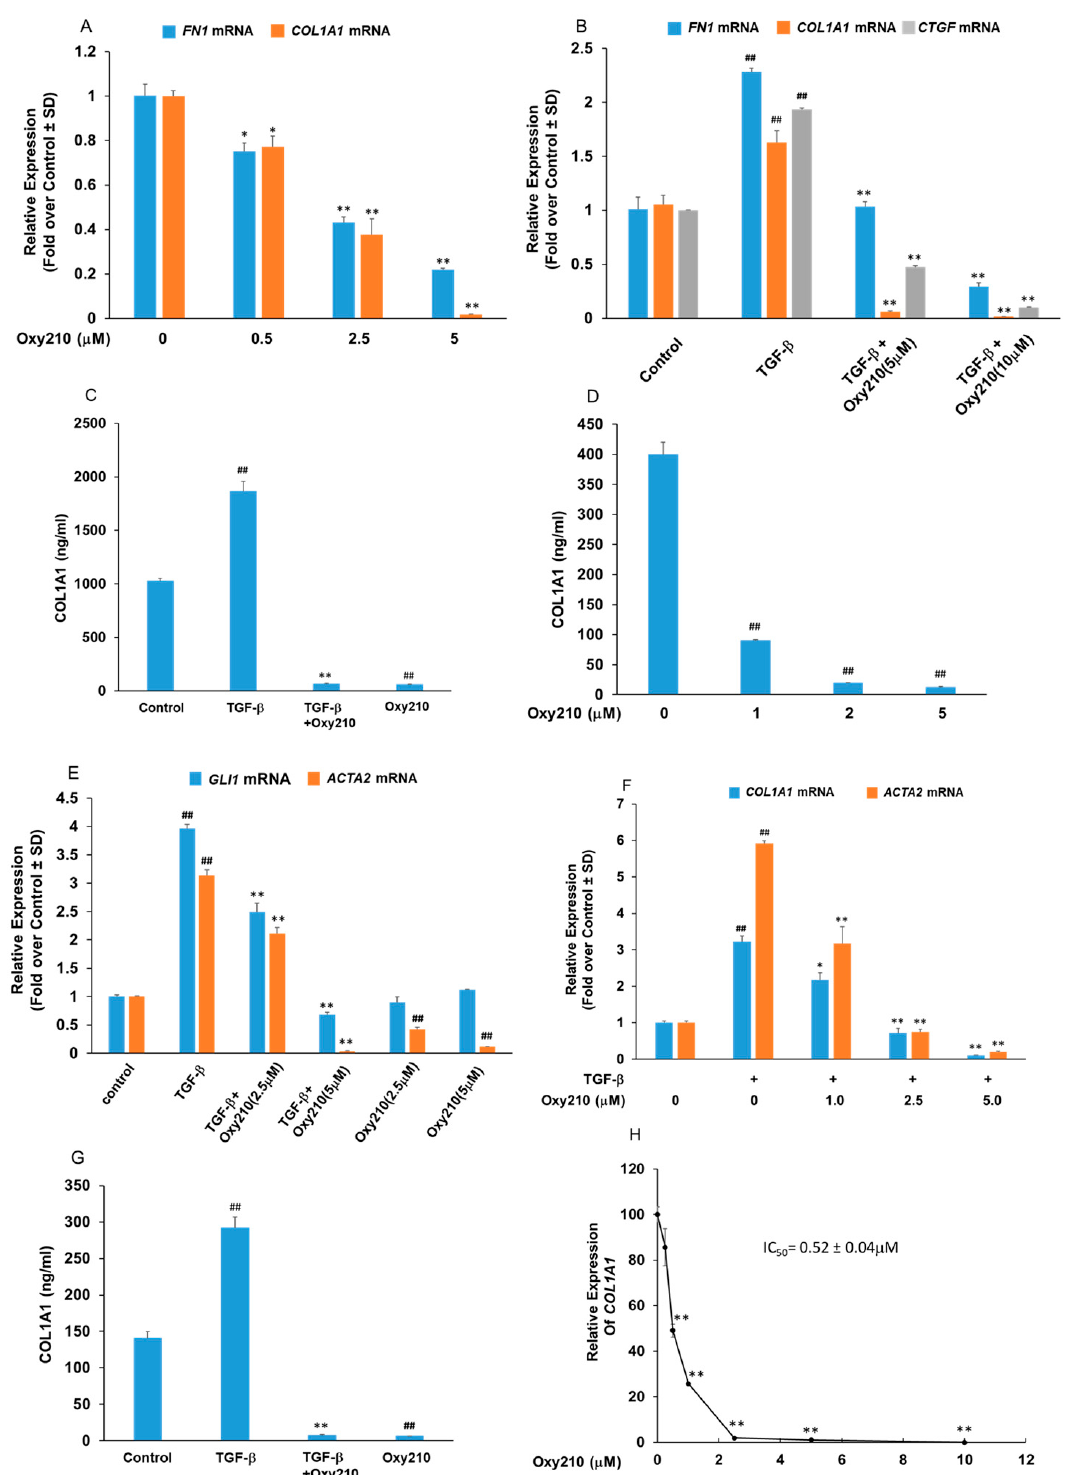
Figure 1. Oxy210 inhibits the basal and TGF- β -induced expression of fibrotic genes . ( A ) IMR-90 cells were treated with Oxy210 in DMEM containing 1% FBS for 72 h and then, RNA was analyzed by Q-RT-PCR for gene expression and normalized to GAPDH . Data from a representative experi- ment are reported as the mean of triplicate determinations ± SD (* p < 0.05 vs. control; ** p < 0.01 vs. control). ( B , E ) IMR-90 cells were pretreated with Oxy210 in DMEM containing 1% FBS for 24 h and then treated with TGF- β 1 (10 ng/mL) in the absence or presence of Oxy210. After 48 h, RNA was analyzed by Q-RT-PCR for gene expression and normalized to GAPDH . Data from a representative experiment are reported as the mean of triplicate determinations ± SD (## p < 0.01 vs. control; ** p <